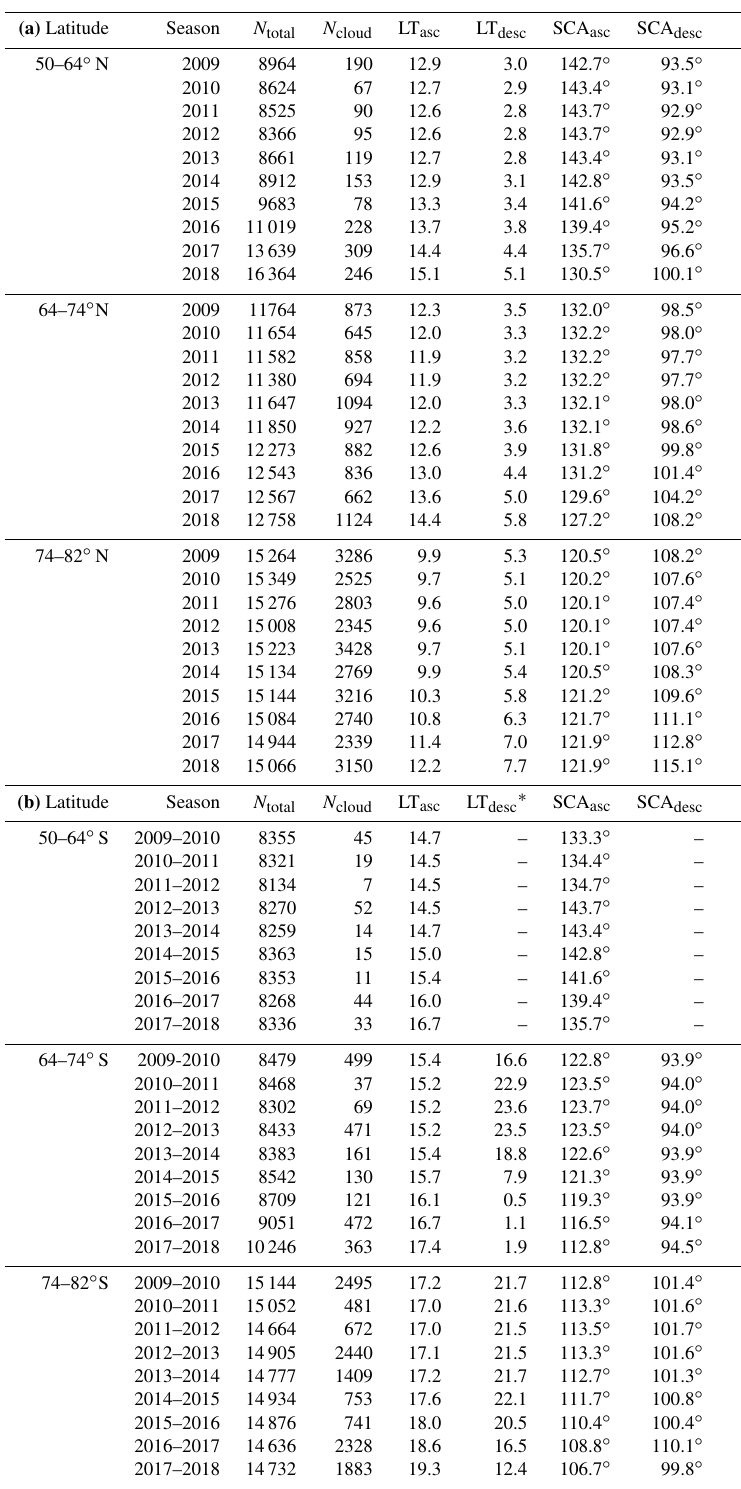
Table 1. (a) Statistics for NOAA-19 SBUV/2 Northern Hemisphere PMC seasons, 2009–2018. (b) Statistics for NOAA-19 SBUV/2 Southern Hemisphere PMC seasons, 2009–2018. (c) Statistics for S-NPP OMPS NP Northern Hemisphere PMC seasons, 2012–2018. (d) Statistics for S-NPP OMPS NP Southern Hemisphere PMC seasons,